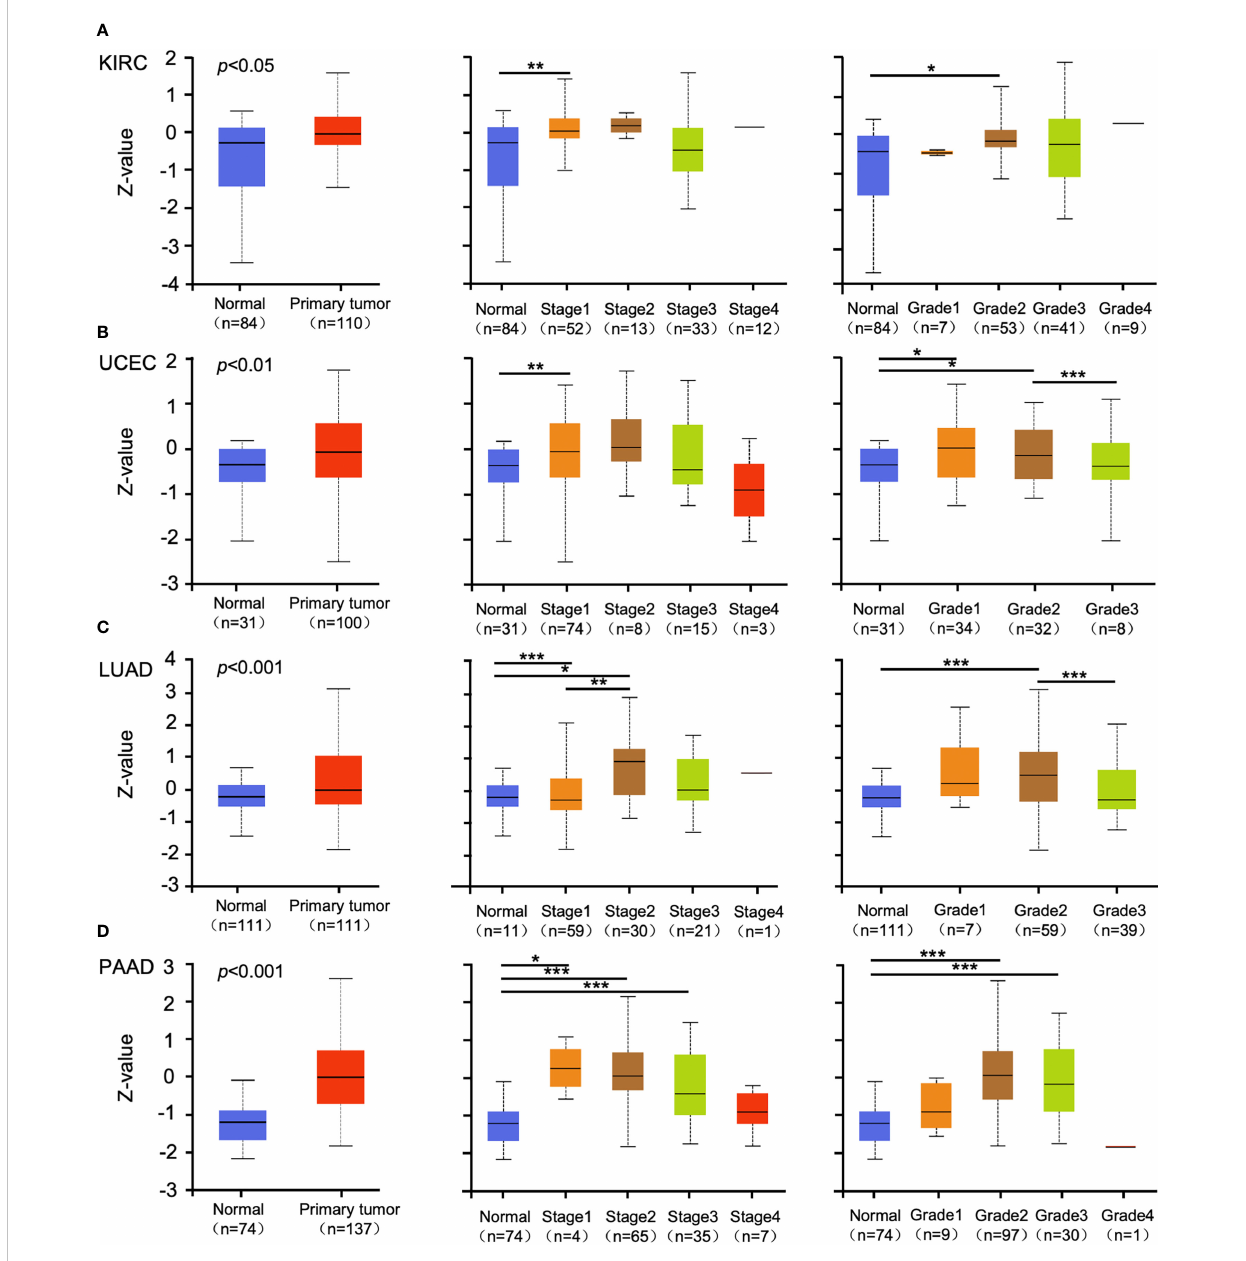
FIGURE 3 The protein expression levels of GSDMB in different cancers. (A – D) The expression levels of the GSDMB protein between normal tissue and primary tissue of KIRC (A) , UCEC (B) , LUAD (C) , and PAAD (D) with different stages and grades were analyzed through the UALCAN from the CPTAC dataset. Based on GSDMB proteomic expression pro fi les of sample types, GSDMB protein expression was signi fi cantly increased in KIRC, UCEC, LUAD, and PAAD primary tumors compared with normal tissue. Based on GSDMB proteomic expression pro fi les of individual cancer stages, GSDMB protein expression was signi fi cantly increased in the KIRC cancer stage 1, UCEC cancer stage 1, LUAD cancer stage 1, LUAD cancer stage 2, PAAD cancer stage 1, PAAD cancer stage 2, and PAAD cancer stage 3 compared with normal. Based on GSDMB proteomic expression pro fi les of tumor grade, GSDMB protein expression was signi fi cantly increased in KIRC tumor grade 2, UCEC tumor grade 1, UCEC tumor grade 2, LUAD tumor grade 2, PAAD tumor grade 2, and PAAD tumor grade 3. Z-values represent standard deviations from the median across samples for the given cancer types. *p < 0.05; **p < 0.01; ***p < 0.001. GSDMB, gasdermin B; KIRC, kidney renal clear cell carcinoma; UCEC, uterine corpus endometrial carcinoma; LUAD, lung adenocarcinoma; PAAD, pancreatic adenocarcinoma; CPTAC, Clinical Proteomic Tumor Analysis